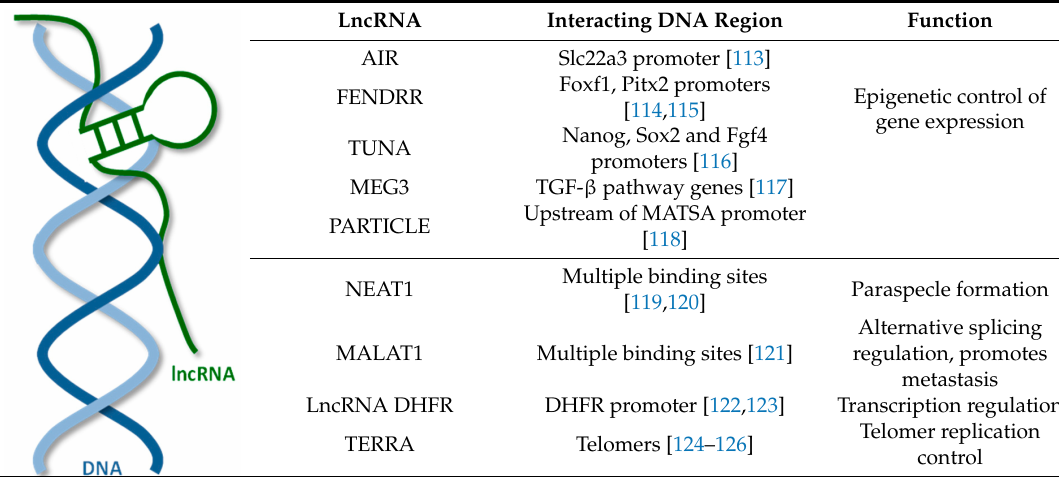
Table 4. Examples of lncRNA interacting with DNA and their postulated